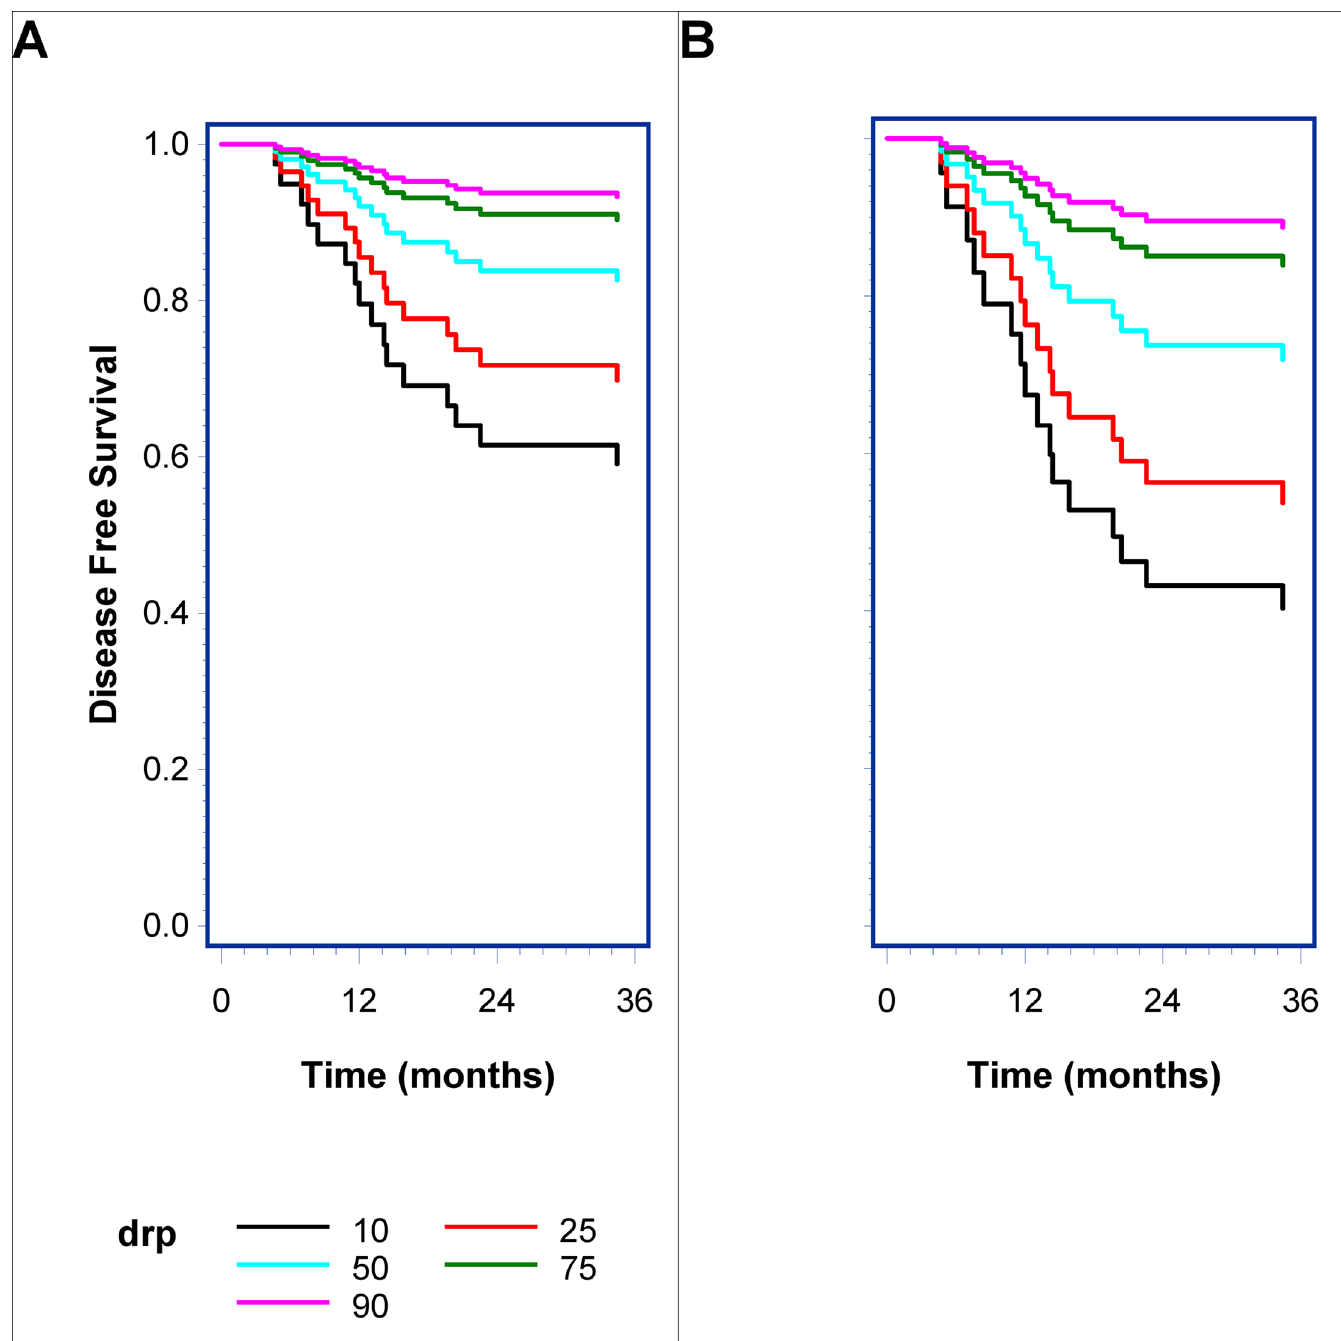
Fig 3. Expected disease-specific survival based on a multivariable model in the ACV cohort of JBR.10. Curves shown for expected disease-specific survival based on the multivariate time-dependent model from JBR.10 with values of the combined profiles (DRP) of 10, 25, 50, 75 and 90 for a model including gender male, age 62 years, histology adenocarcinoma and stage 1 (A) and stage 2